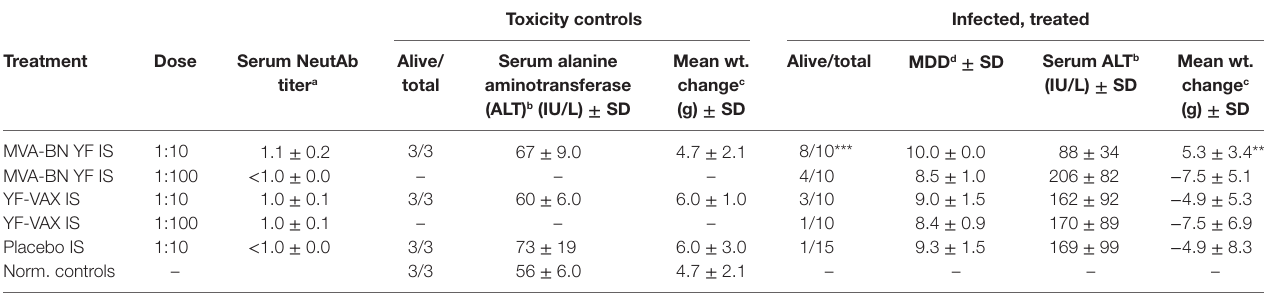
a Average log 10 neutralizing antibody titer of serum collected 4 h prior to virus challenge and quantified by PRNT 50 . b Serum ALT levels collected on 6 dpi. c Difference between weight on 3 and 6 days post-virus challenge representing maximal weight change within this study. d Mean day to death of animals that succumb to disease during the experimental period of 21 days.